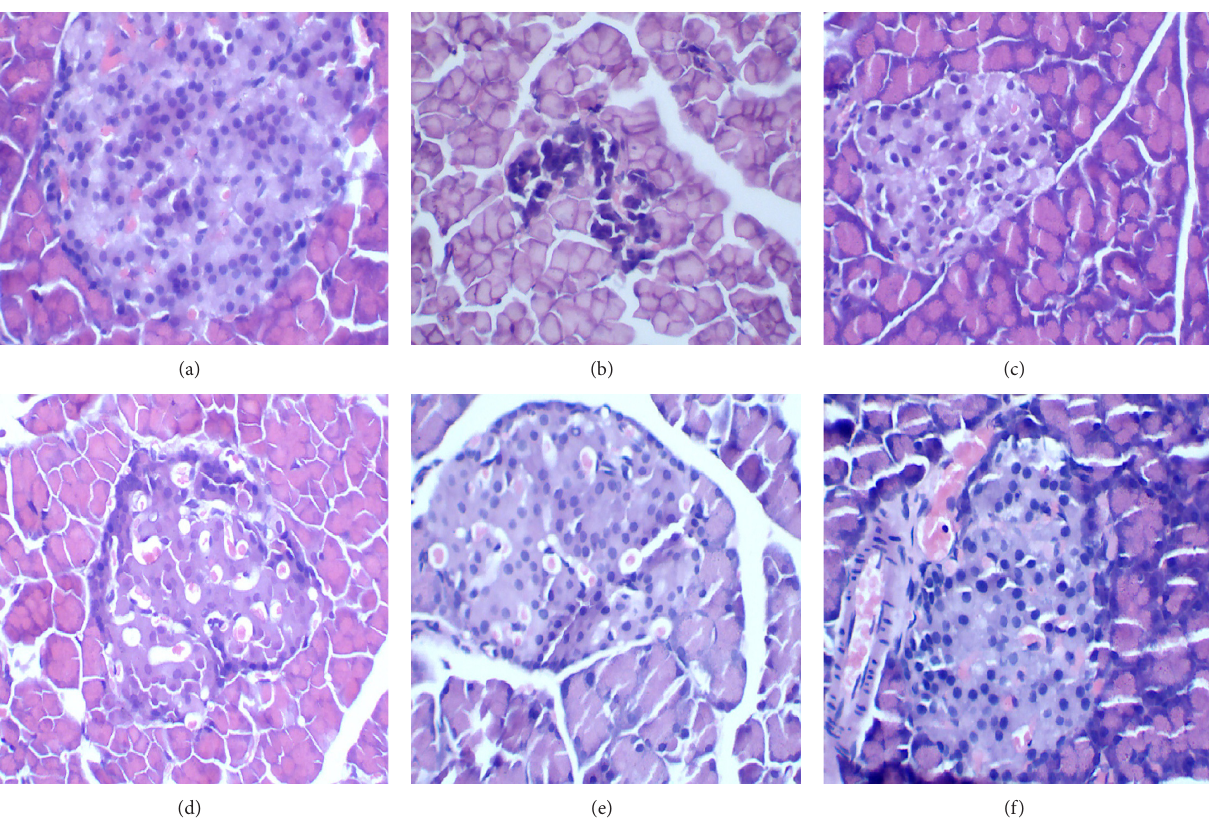
Figure 2: The pathological examination result of pancreatic islets in STZ-induced diabetic rats. (a) Pancreatic islet from a normal mouse. (b) Pancreatic islet from STZ-induced diabetic rats with no treatment, severe degranulation of most 𝛽 -cells in this islet. (c) and (d) Pancreatic islet from STZ-induced rats treated with Met and Glic, respectively. (e) and (f) Pancreatic islet from STZ-induced rats treated with TNTL (1.26 and 0.63 g/kg b.w.,